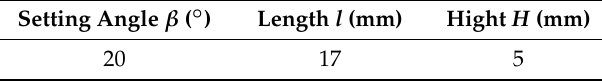
Table 2. Ratio of VG Height to Different BL Thickness.